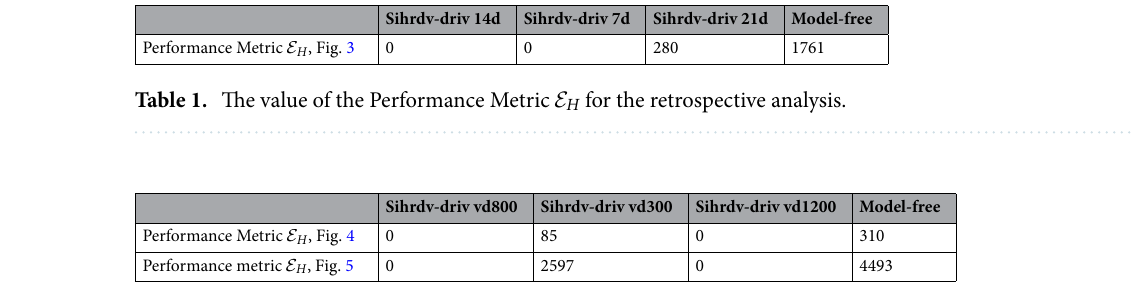
Table 2. The value of the Performance Metric E H for the retrospective